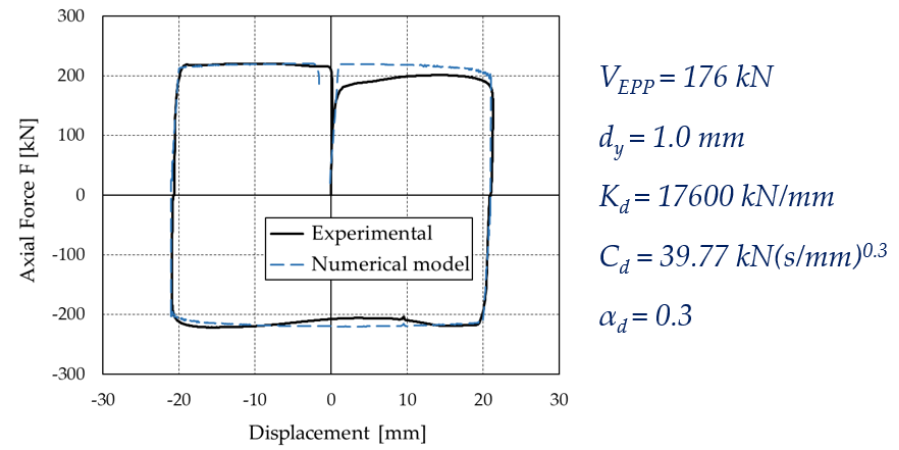
Figure 7. Matching of the numerical model with the experimental curve, and identified parameters of the EPPV model, adapted from [7].